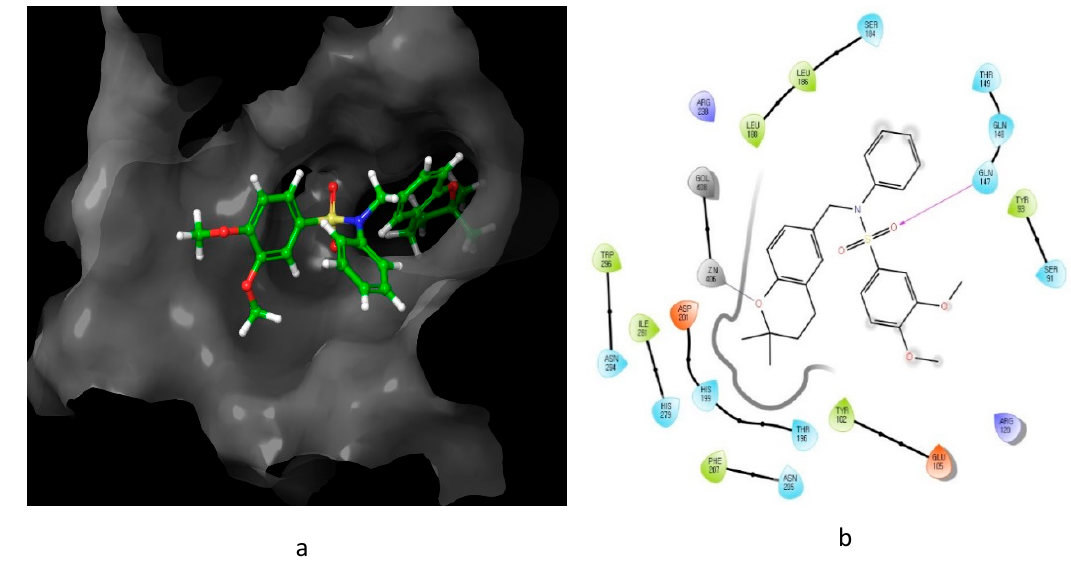
Figure 8. Predicted interaction of compound 13 with hypoxia-inducible factor active site residue. ( a ) 3D structural view of the sulfonamide ligand inside the receptor’s active site. ( b ) Ligand interaction diagram; violet lines represent hydrogen bonds and grey lines represent metal interaction.